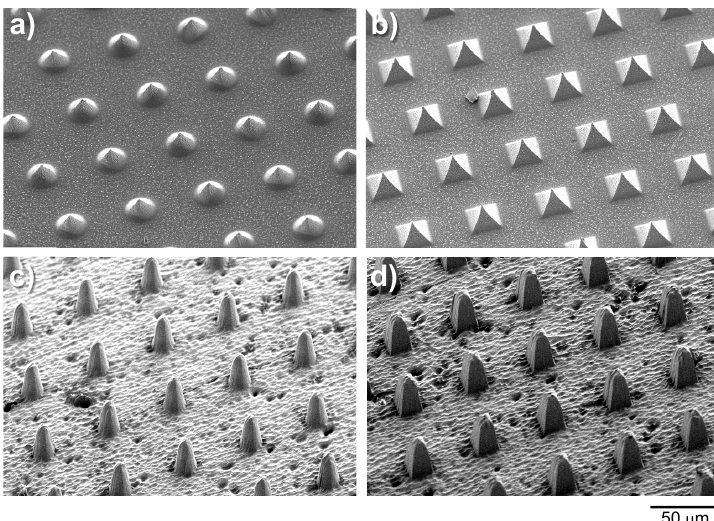
Figure 9. SEM images of the Si absorbers on the X-ray grayscale mask before spin-coating of SU-8: ( a ) cone and ( b ) pyramid shape. SEM images of the PMMA microstructures fabricated by X-ray lithography at the dose energy of 300 mA·h; ( c ) cone and ( d ) pyramid shape. Reprinted with permission from [22].